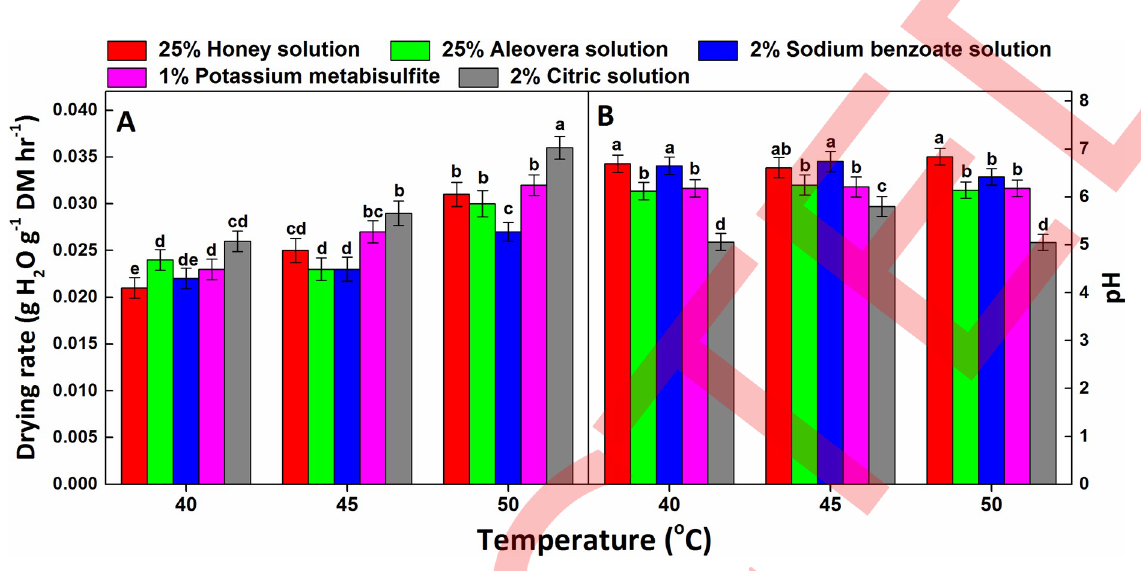
Fig 3. The effect of drying temperature and preservatives on drying rate (A) and pH (B) of persimmon fruit. Bars in the figure represent means ± S.E. (n = 3), and means sharing the same letters are non-significant at p <